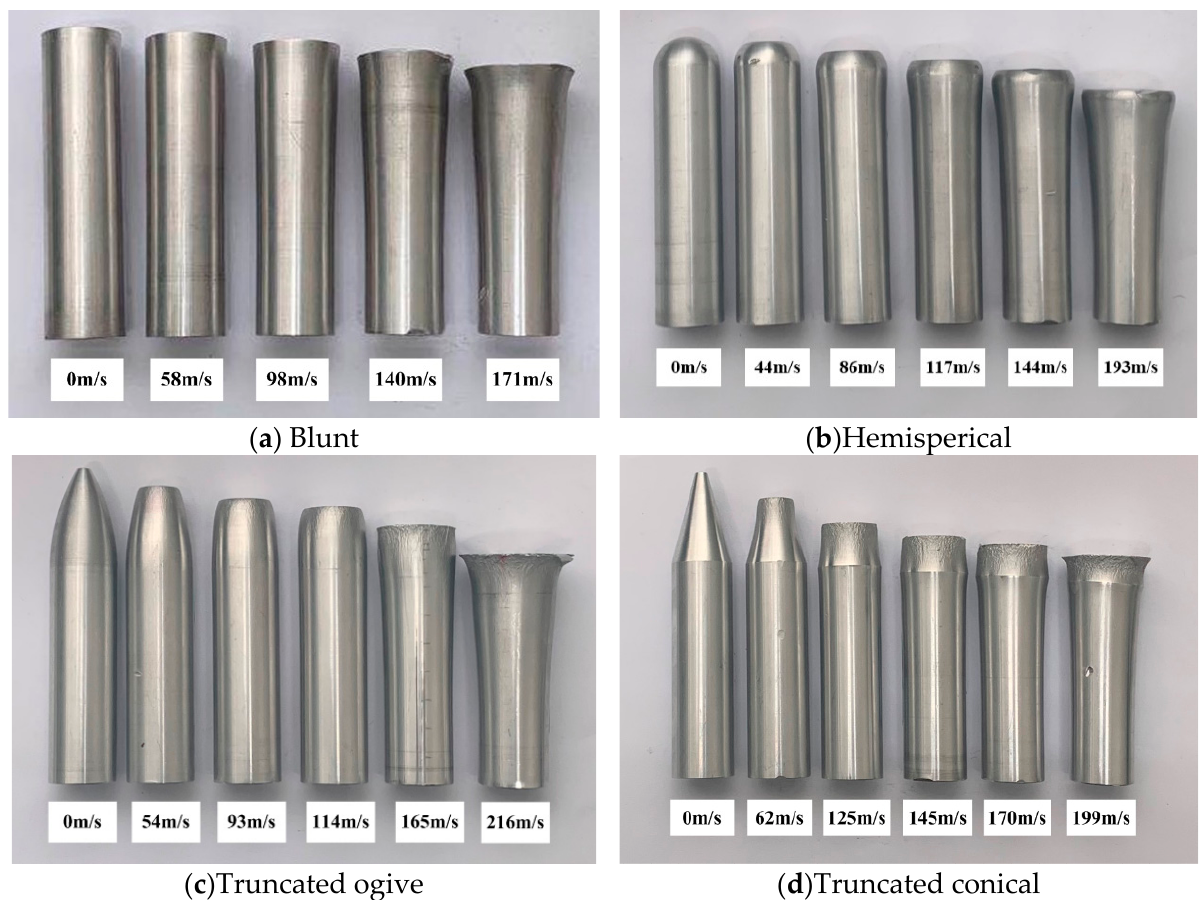
Figure 11. Contour contrast of recovered projectiles under different impact velocities.